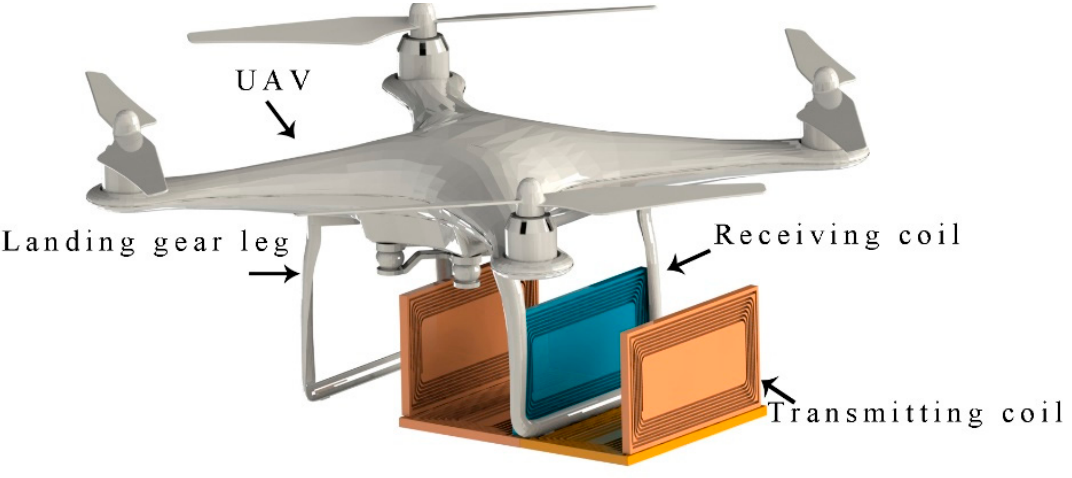
Figure 1. Diagram of a wireless charging system for drones.